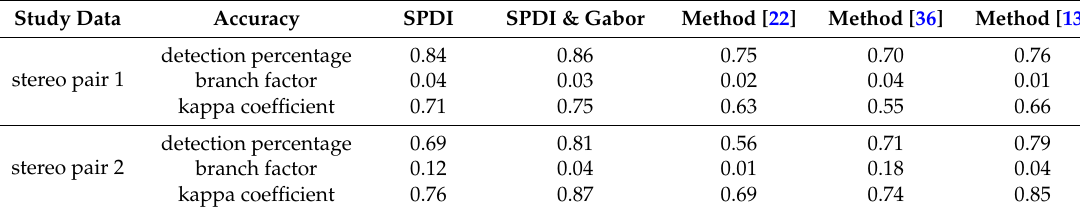
Table 2. Accuracy results of five built-up area identification